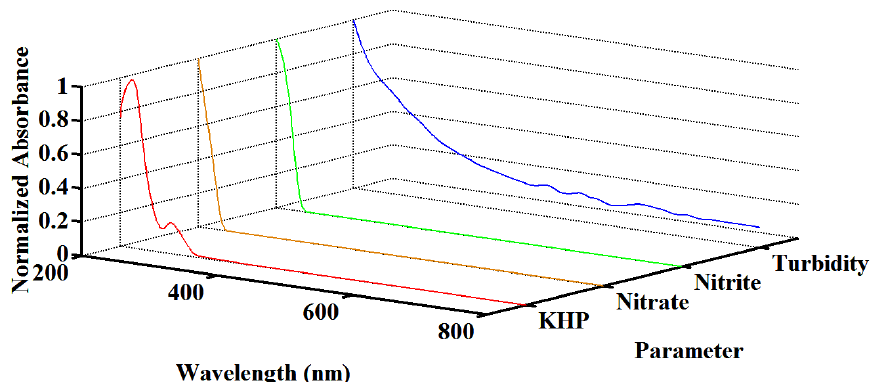
Figure 7. Normalized characteristic curves of multiple parameters. Sensors 2018 , 18 , x FOR PEER REVIEW